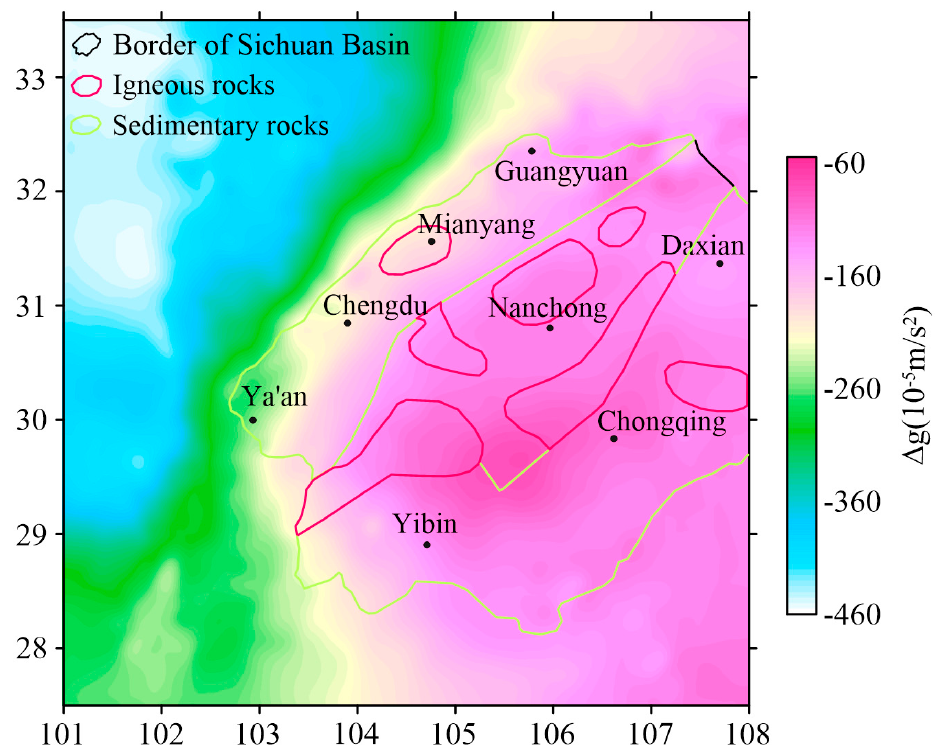
Figure 2. Map of the Bouguer gravity anomalies in central and western Sichuan Basin (modi fi ed from Zhou [13] and Chen et al. [17]).